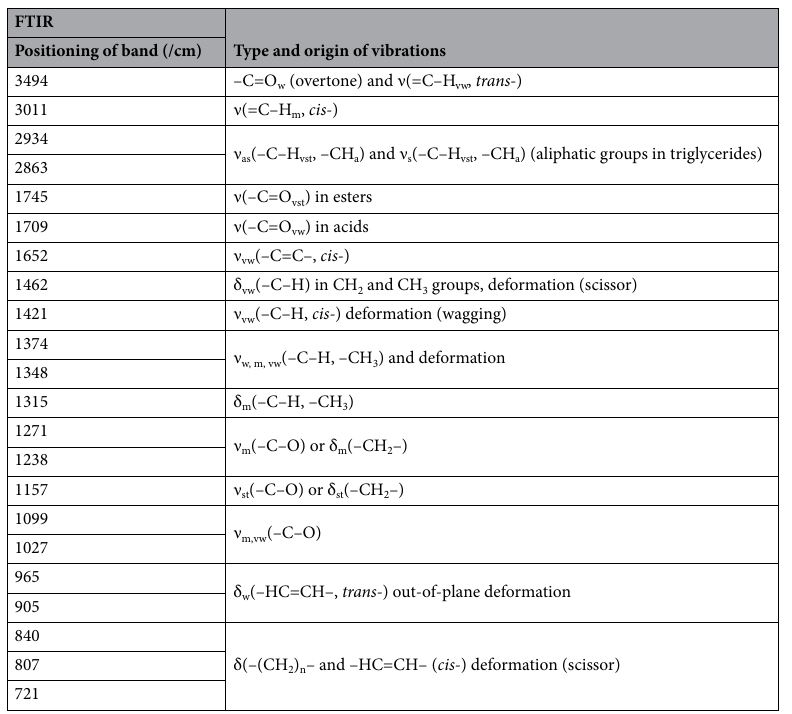
Table 4. The location of the maxima of the FTIR absorption bands, with the assignment of particular vibrations to the respective samples: Dornfelder 2015, Hibernal 2017, Neuburger 2017, Pálava 2015, Pinot Gris 2015, Riesling presents all the 2015, Sauvignon 2017, Tramin 2015, Zweigeltrebe 2015 and Zweigeltrebe 2017, registered within the spectral range of 700–3600/cm. ν stretching vibrations, δ deformation vibrations, s symmetric, as asymmetric, st strong, w